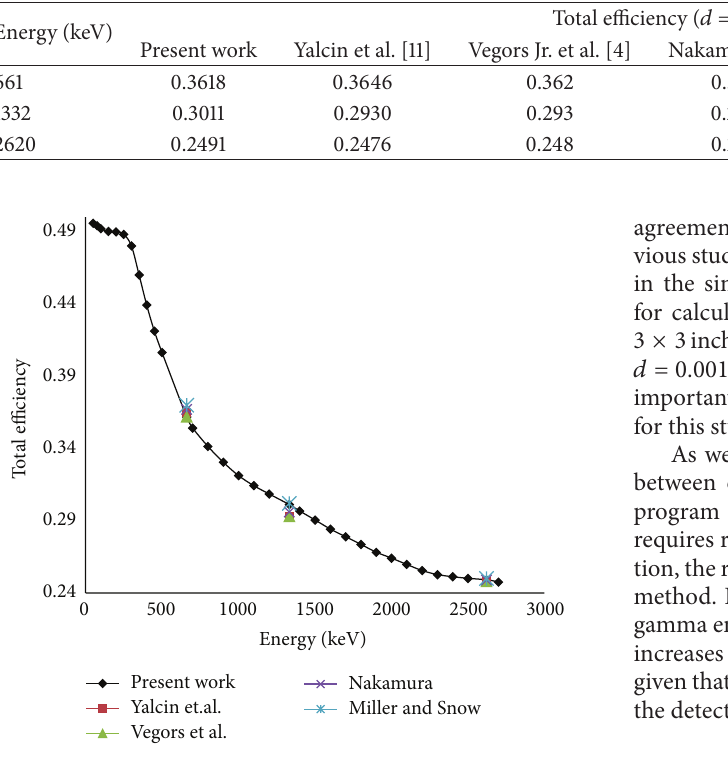
Figure 3: Total efficiency for 3 × 3 inch NaI(Tl) detector ( 𝑑 = 0.001